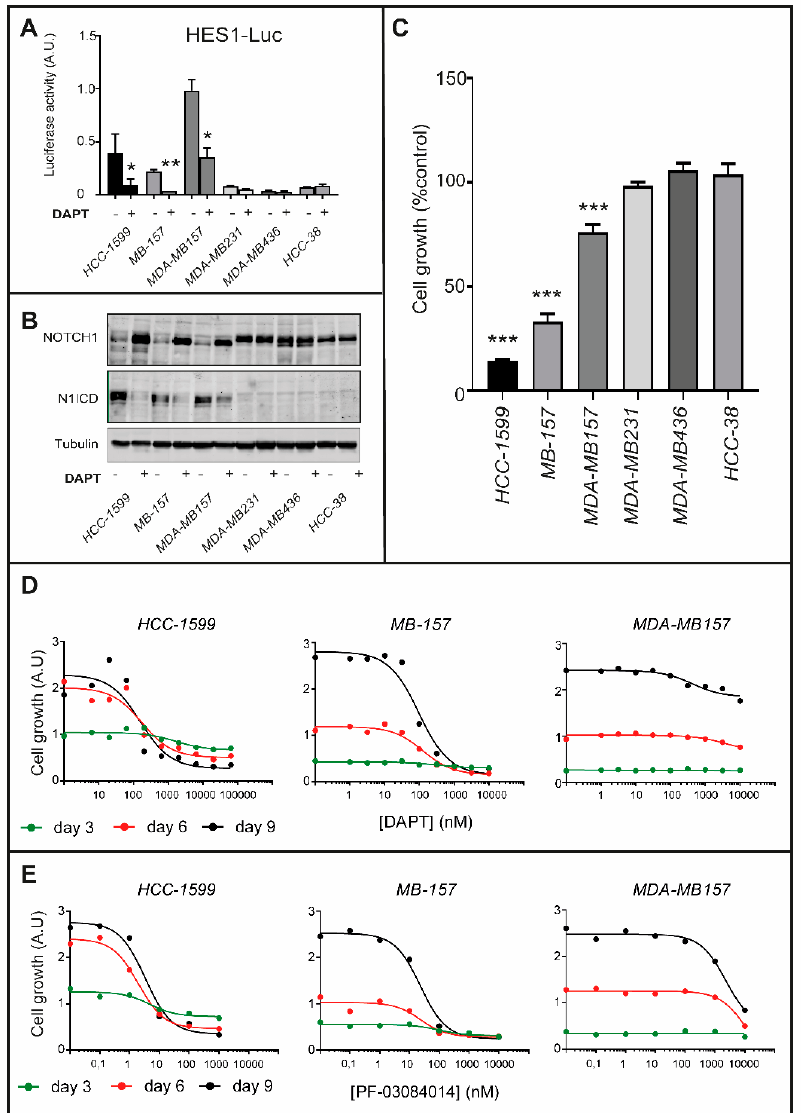
Figure 2. NOTCH1 signaling in ATRA-sensitive/ATRA-resistant TNBC cell lines and role in cellular growth. ( A ) The indicated cell lines were transfected with the reporter plasmid pGL2HES-1/LUC ( HES1-Luc ). The HES1-Luc plasmid construct contains the luciferase cDNA under the control of